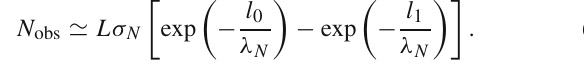
be determined. 8 Hence, one can expect relative sensitivity √ 1 . 22 m / l 1 . Relation (4) also permits to estimate gains ∝ the sensitivity gain by increasing the integrated luminosity L (e.g. by extending the Z -pole run or by considering more than one IP): Increasing L by a given factor has the same effect as increasing l 1 by the same factor. Hence, for given M , the valueof U 2 neededtoachieveagivennumberofeventsscales √ L . As an example we display the gain in sensitivity as ∝ 1 / that could be achieved with the inner detector by doubling the integrated luminosity of the Z -pole run (faint dashed red curve). The scaling of all lines in the plot with increased integratedluminositycanbeestimatedbycomparingthefaint dashed red line to the faint solid red curve, and with relation (4). All HECATE lines would scale with the number of Z - bosons in the same way as the main detector line, we omit them here to keep the plot readable. We further do not